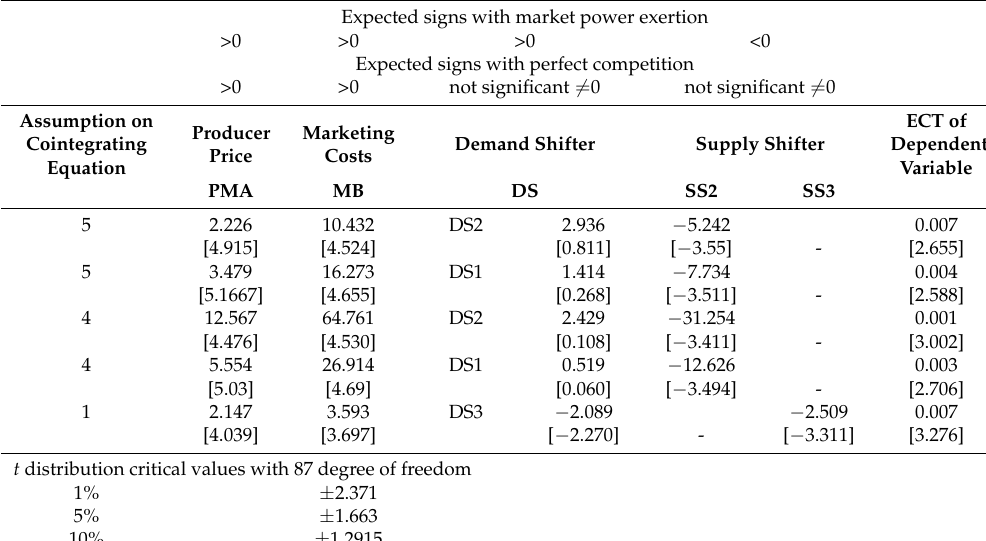
Table 2. Dataset A (January 1996–October 2003) ECM cointegrating vectors parameters [ t values] normalized with respect to retail price (91 observations, two lags in